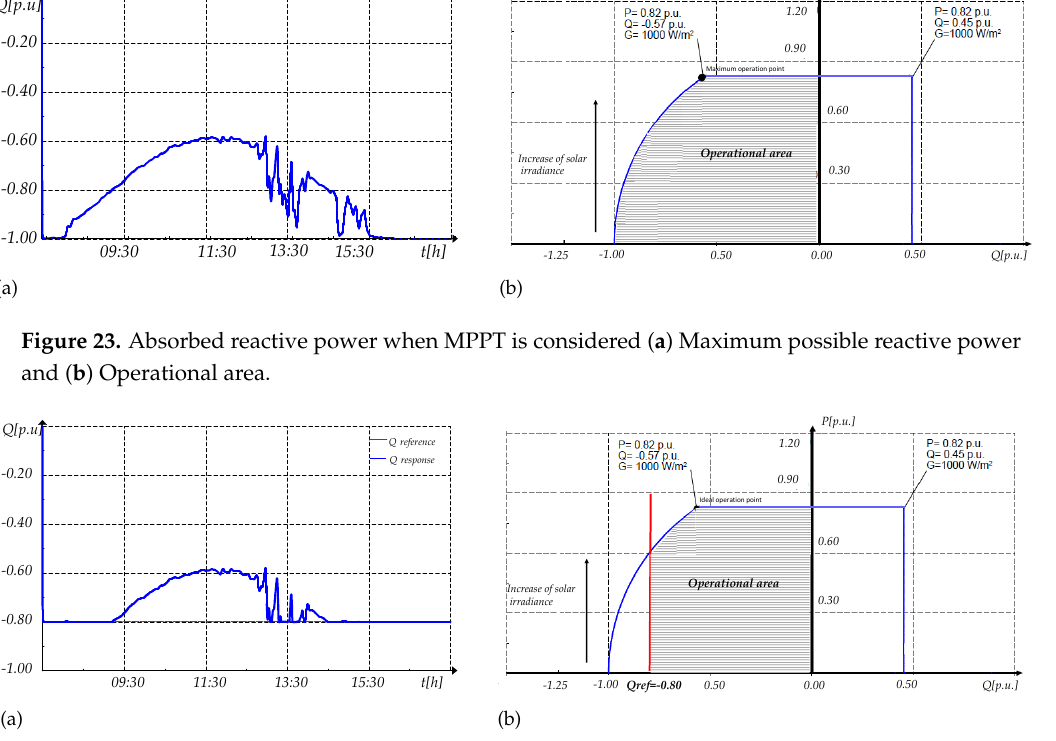
Figure 24. Absorbed reactive power when a reference of reactive power is considered ( a ) Response of reactive power ( b ) Operational